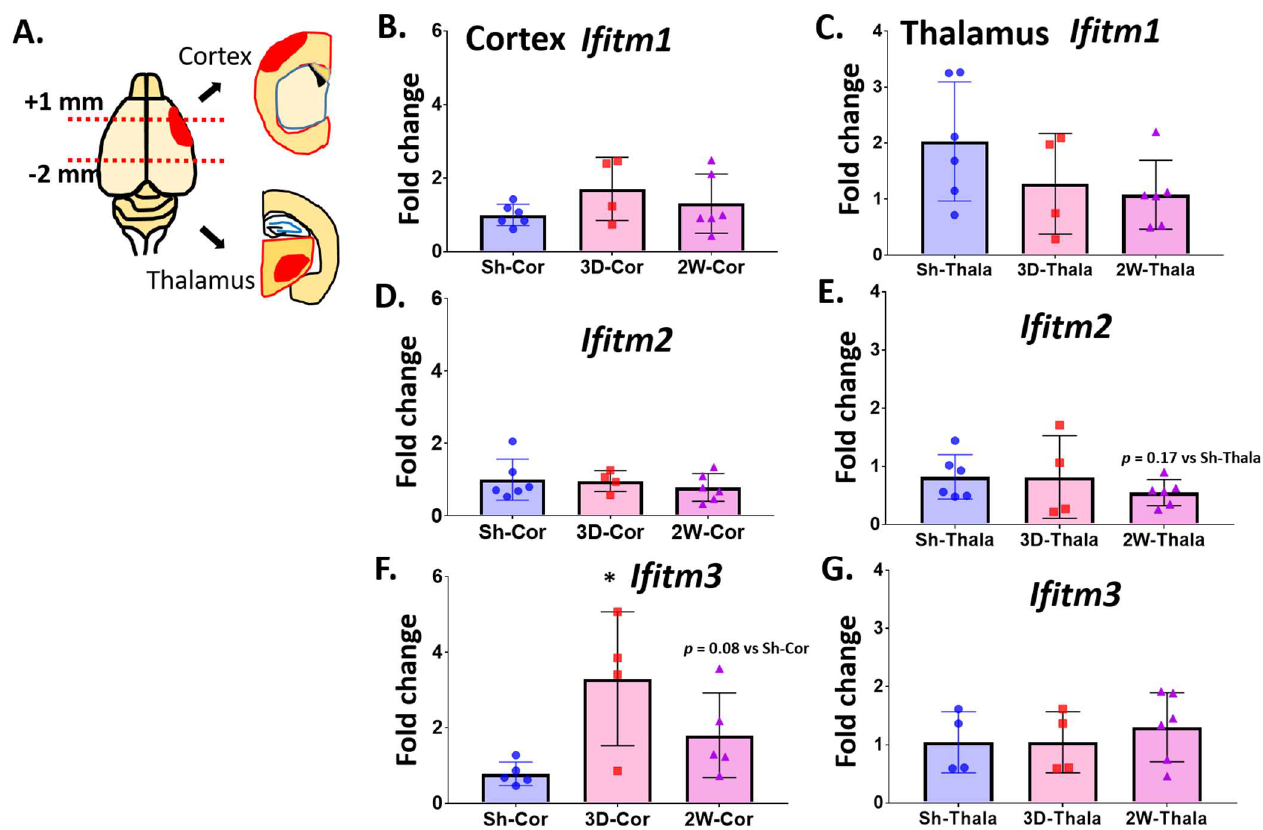
Figure 3. Ifitm3 is markedly induced in the damaged cortex of post-stroke brains. Ischemic stroke was induced by permanent distal middle cerebral artery occlusion using C57BL6 male mice (18–20 months old). At 3 days and 2 weeks after surgeries, brains were separated into cortex and thalamus ( A ). After isolation of RNA, qRT-PCR was performed to measure gene expression for IFITM family genes. Ifitm1 levels in ( B ) the cortex and ( C ) thalamus of sham, PSD 3 and PDS 14 brains was measured by qRT-PCR ( n = 4–6). Ifitm2 levels in ( D ) the cortex and ( E ) thalamus of sham, PSD 3 and PDS 14 brains was measured by qRT-PCR ( n = 4–6, p = 0.17 vs. Sh-Thala). Ifitm3 levels in ( F ) the cortex and ( G ) thalamus of sham, PSD 3 and PDS 14 brains was measured by qRT-PCR ( n = 4–6, * p < 0.05). One-way ANOVA with Tukey’s post hoc tests, p = 0.17 vs. Sh-Thala, p = 0.08 vs. Sh-Cor, two-tailed unpaired Student’s t -test.